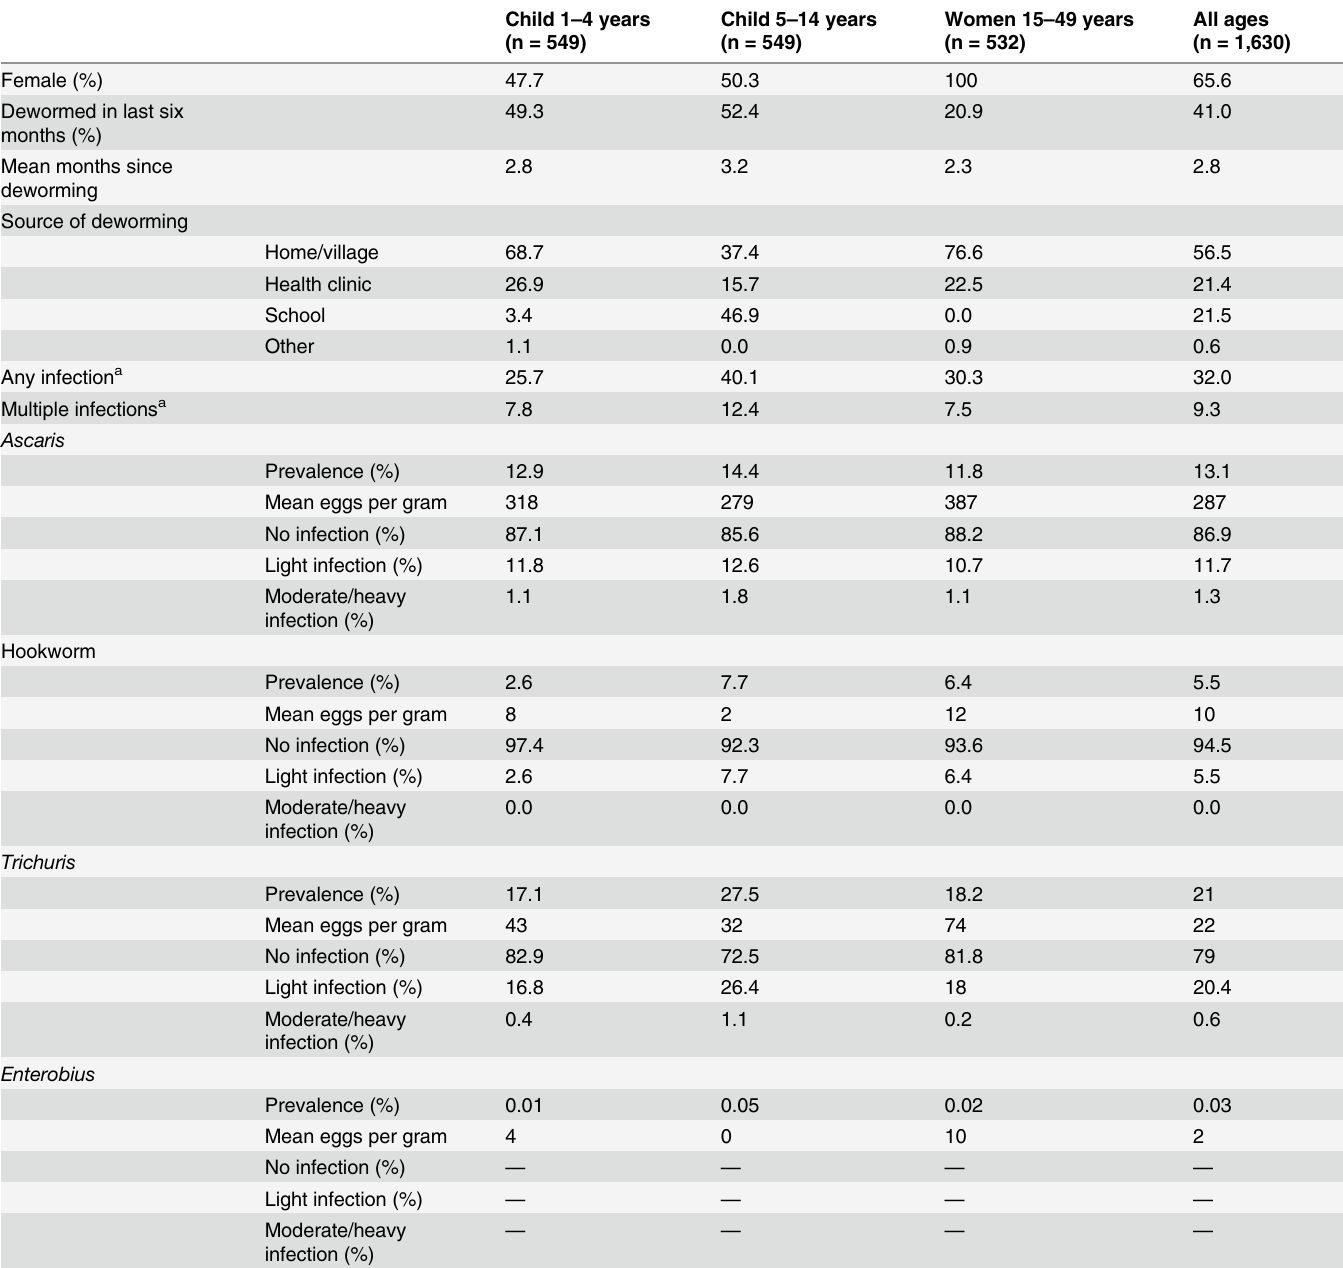
Table 1. Helminth infection prevalence by age, helminth, and infection